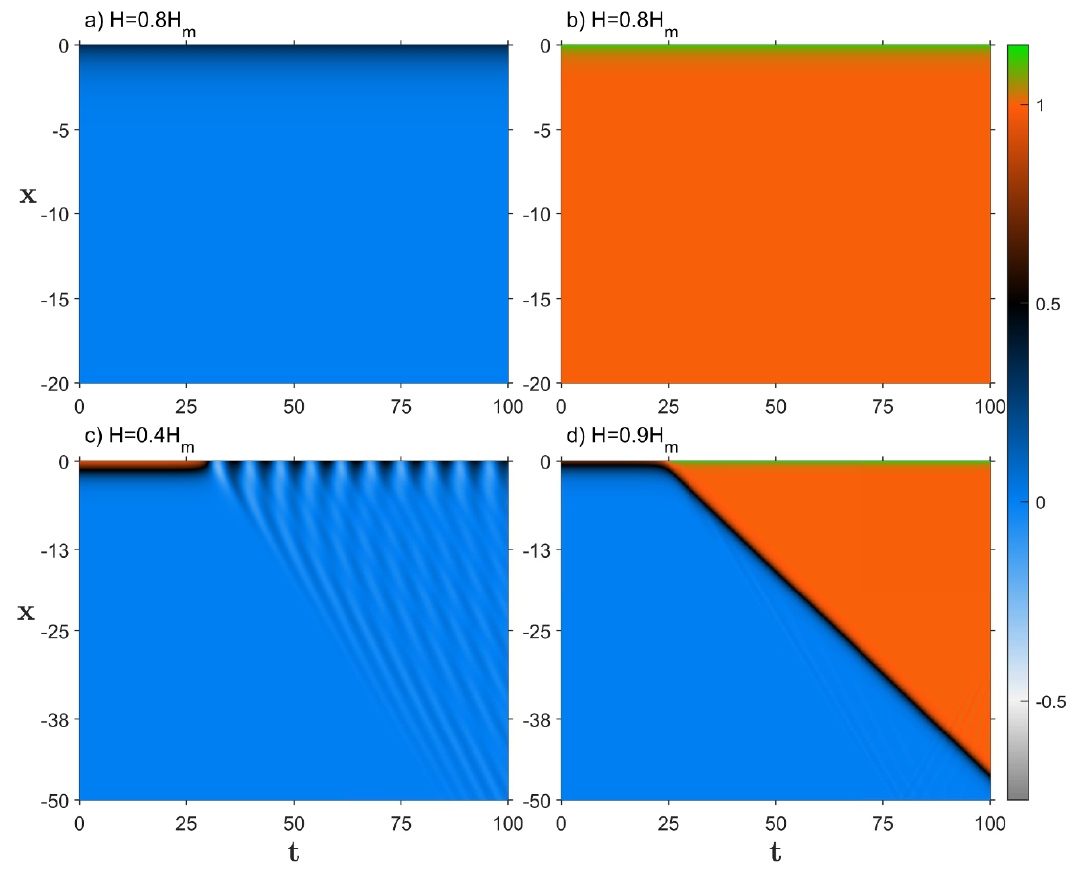
Figure 9 . Stability analysis of the boundaries: a) unchanging of φ 1 ( x ) configuration, compatible with stability; b) unchanging of ˜ φ 3 ( x ) configuration, compatible with stability; c) emission of radi- ation by the unstable φ 2 boundary; d) emission of a kink by the unstable φ 2 boundary. The values of H are shown in the